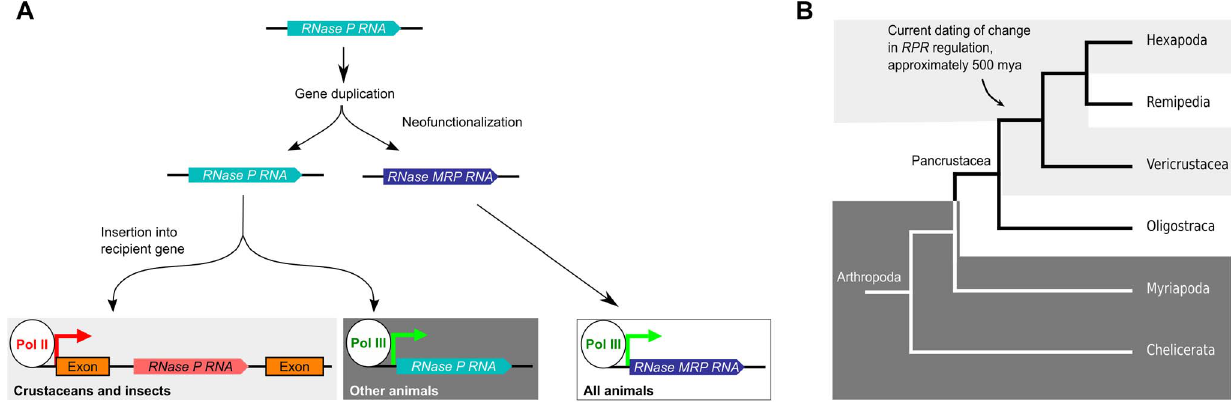
Fig. 6. Model for the evolutionary history of RPR . A. An ancestral RPR gene is thought to have undergone gene duplication and one of the daughter genes assumed the new functions of MRP RNA (neofunctionalization). MRP RNA is transcribed by pol III in all animals, as is RPR in animals previously characterized. We found that the RPR gene in crustaceans and insects has undergone another genetic event that inserted it, devoid of pol III signals, into a pol II-transcribed gene. B. A cladogram showing arthropod evolution (based on, [26,27,65]). In Hexapods and true crustaceans (Vericrustacea) (light grey), RPR is embedded in a pol II-regulated gene. In contrast, in Myriapoda and Chelicerata, RPR is a pol III gene (dark grey). The RPR genes in Remipedia and Oligostraca have not been characterized due to lack of genomic sequences (unshaded). The arrow indicates a node that connects branches where RPR is found in a recipient gene. These groups are thought to have diverged 500 million years ago [18,66]. We predict that Remipedia RPR is also embedded in a recipient gene similar to the sister group Hexapoda. An analysis of RPR in Oligostraca will enable us to determine if embedding of RPR occurred earlier in arthropod evolution in an ancestor of all pancrustaceans.